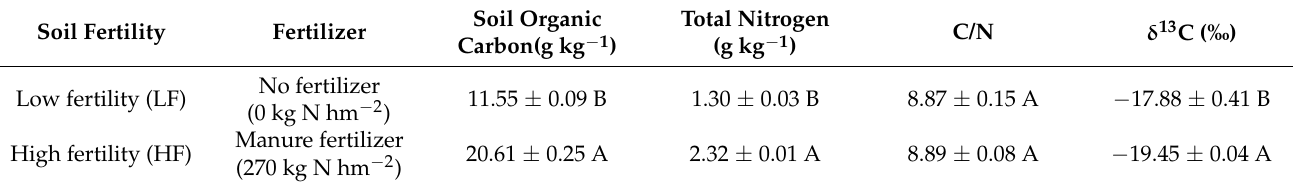
Table 1. Basic properties of the tested soil (0–20